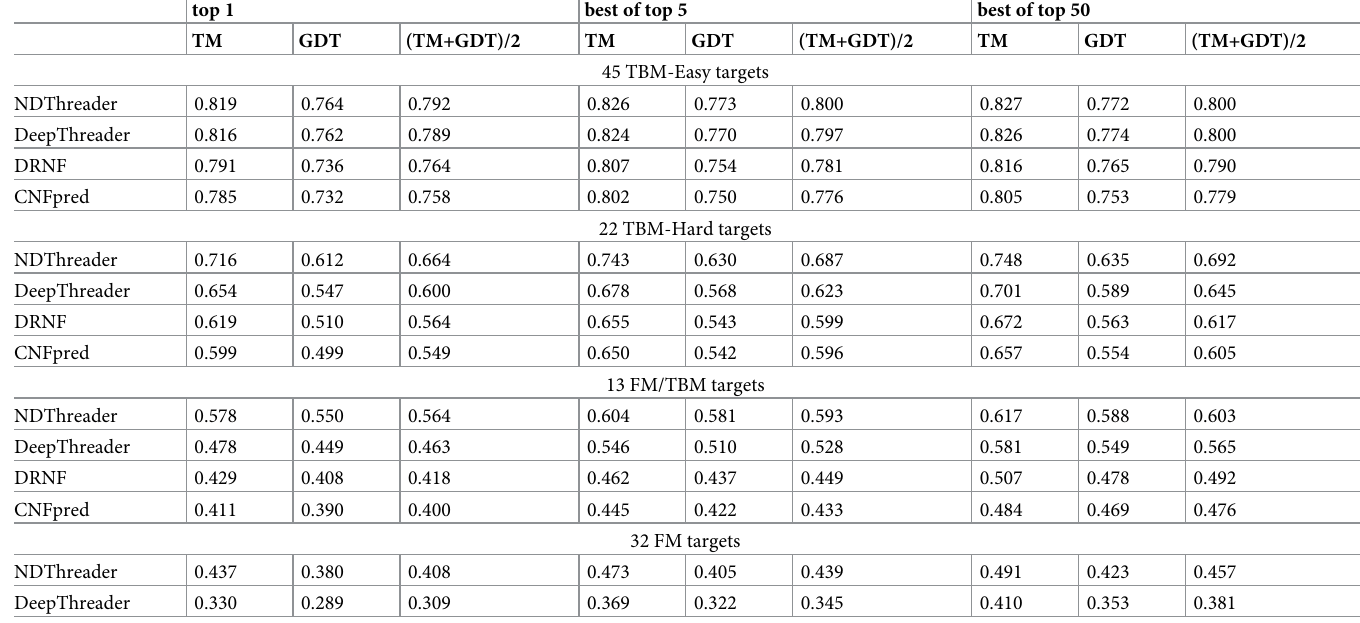
Table 3. The threading performance on the CASP13 targets. GDT is scaled to [0,